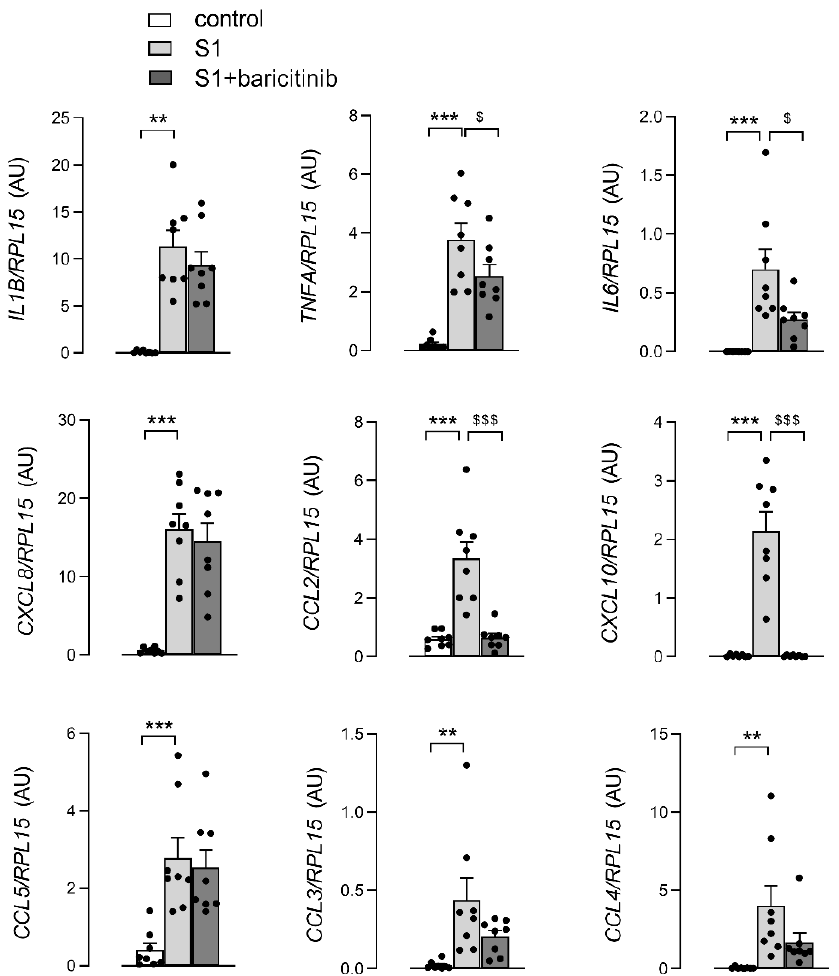
Figure 1. Monocyte-derived macrophages (MDM) were left untreated (control) or incubated for 4 h with 5 nM spike S1 protein in the absence (S1) or in the presence of 1 µM baricitinib (S1+baricitinib). The expression of the indicated genes was measured by means of RT-qPCR and calculated relatively to that of the housekeeping gene RPL15 , by employing the ∆∆Ct method. Bars are means ± SEM of eight independent determinations (single dots), each performed in duplicate. ** p < 0.01, *** p < 0.001 vs. untreated cells (control); $ p < 0.05, $$$ p < 0.001 vs. S1-treated cells with one-way ANOVA.